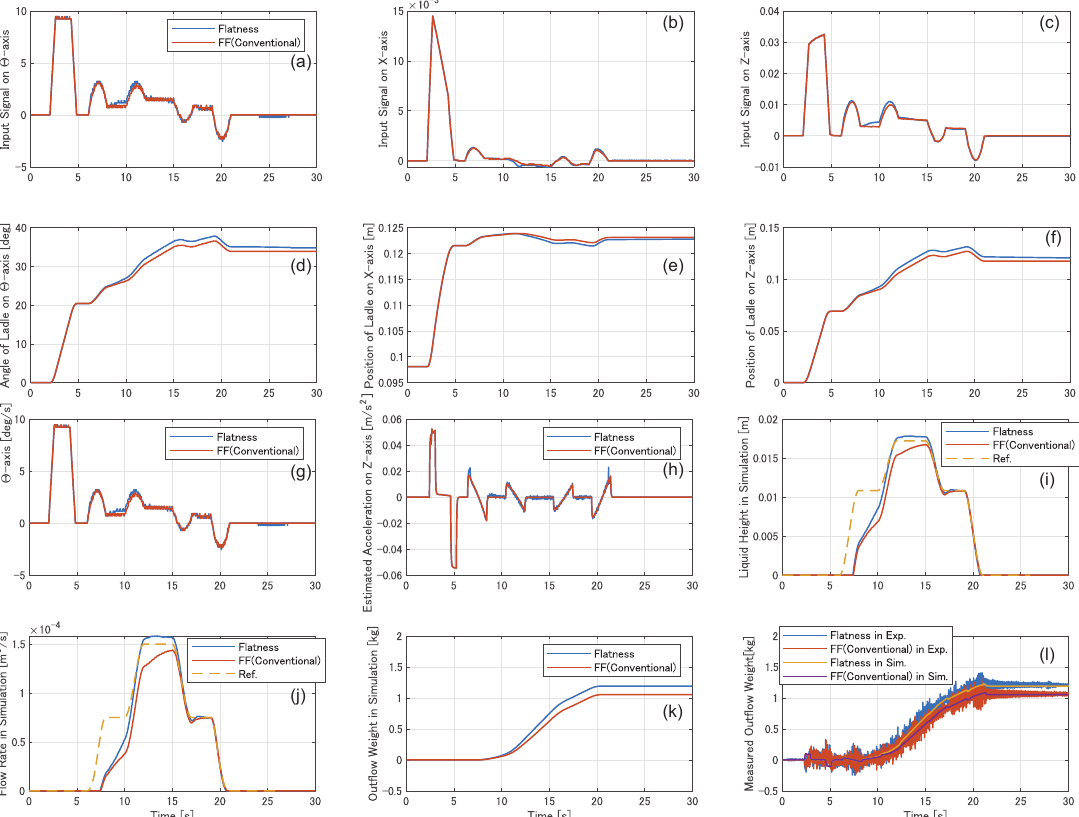
Figure 12. Experimental results of flow rate control to pouring process with disturbance. ( a ) Input signal added to motor of the Θ -axis. ( b ) Input signal added to motor of the X -axis. ( c ) Input signal added to motor of the Z -axis. ( d ) Angle of tilting ladle on Θ -axis. ( e ) Position of ladle on X -axis. ( f ) Position of ladle on Z -axis. ( g ) Angular velocity on Θ -axis, estimated by steady-state Kalman filter. ( h ) Acceleration on Z -axis, estimated by steady-state Kalman filter. ( i ) Liquid height at pouring mouth in simulation, using pouring model. ( j ) Flow rate of outflow liquid in simulation, using pouring model. ( k ) Weight of outflow liquid in simulation, using pouring model. ( l ) Weight of outflow liquid, measured by load cell.